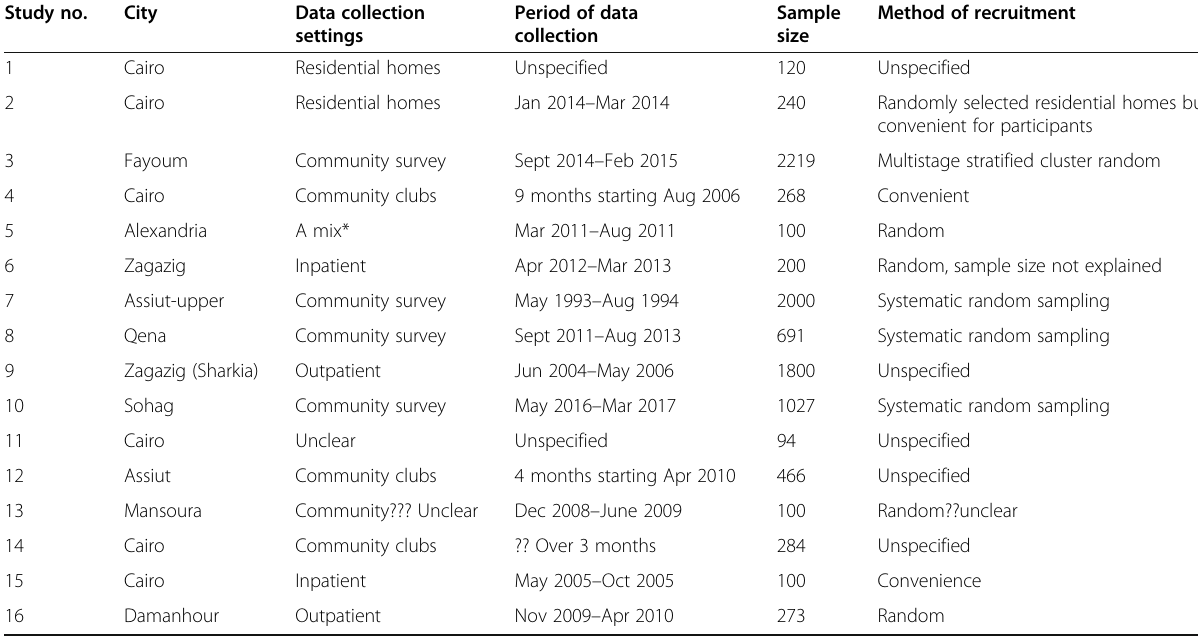
Table 2 Sample and population of included studies Study